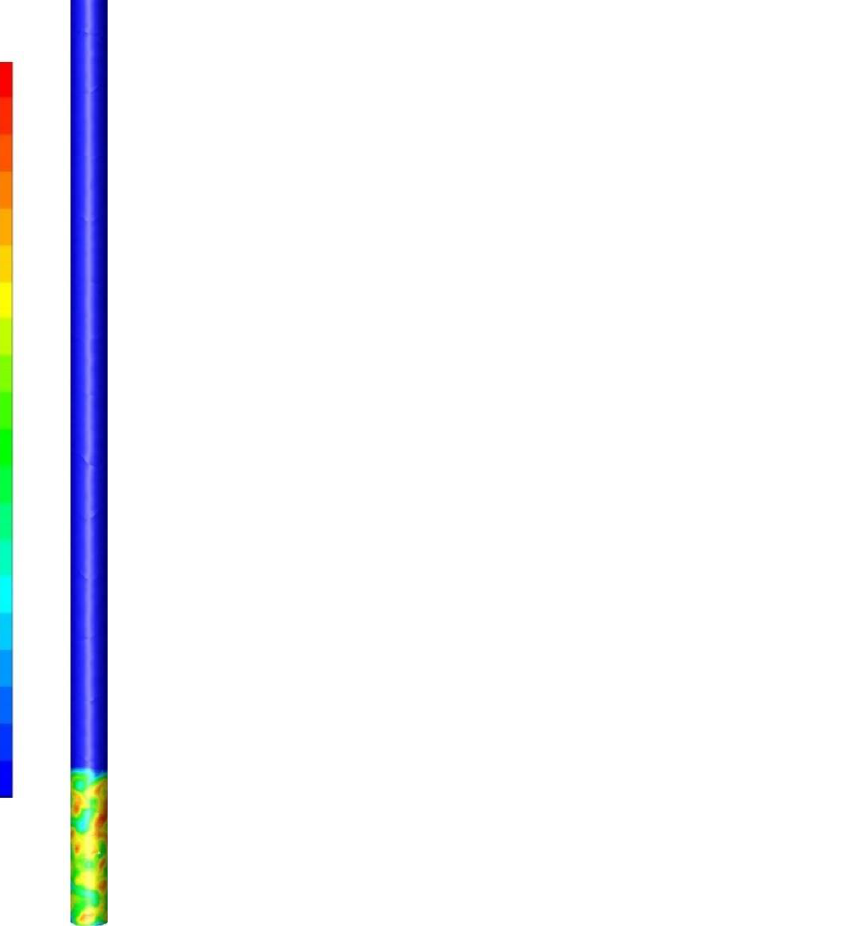
Figure 3. Solid phase volume fraction for the case of a catalyst mass of 100 g, a gas velocity of 0.016 m/s and a temperature of 575 °C.